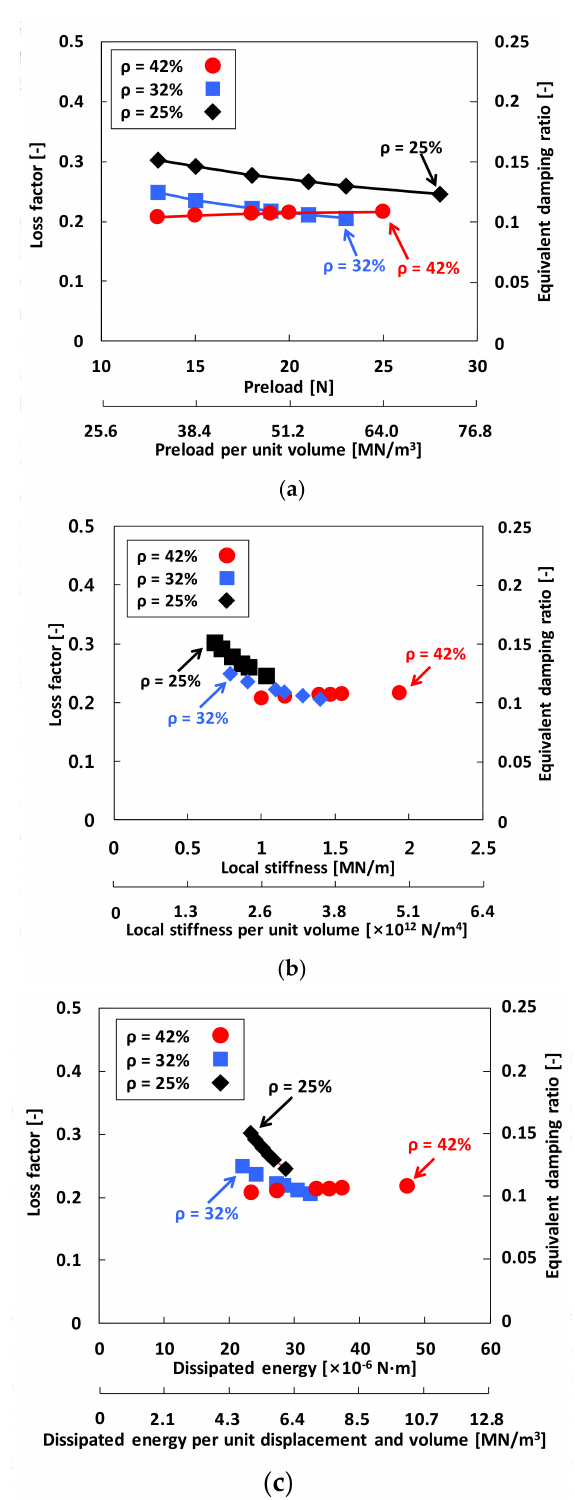
Figure 12. Local hysteresis loop measurements: WMD loss factor γ (left vertical axis) and equivalent damping ratio ζ eq (right vertical axis) versus ( a ) preload F Pre (upper horizontal axis) and preload F Pre per unit volume of WMD (lower horizontal axis), ( b ) local stiffness K Local (upper horizontal axis) and local stiffness K Local per unit volume of WMD (lower horizontal axis), and ( c ) dissipated energy E dis (upper horizontal axis) and dissipated energy E dis per unit displacement and volume of WMD (lower horizontal axis). The circle, square, and diamond symbols denote loss factors of the WMDs with 42%, 32%, and 25% densities,